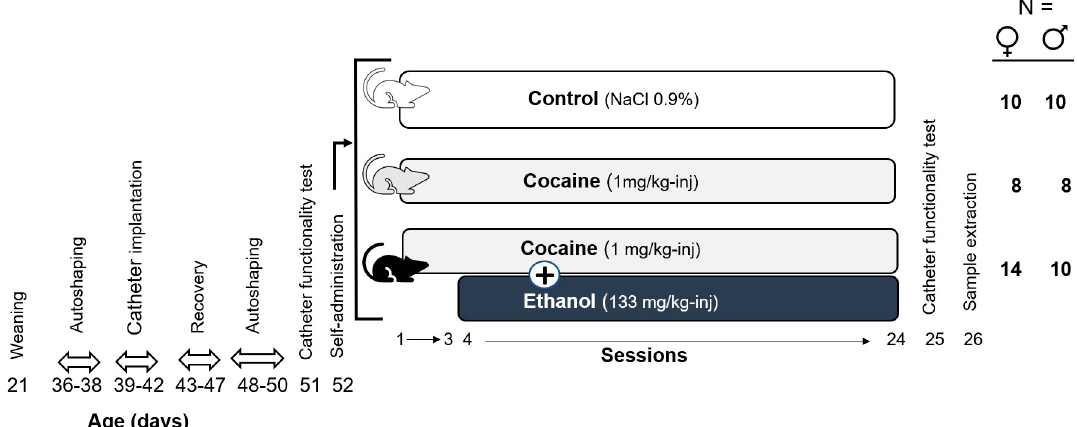
Fig 1. Scheme of the experimental design. From the fourth session the C+E group received ethanol along with cocaine.